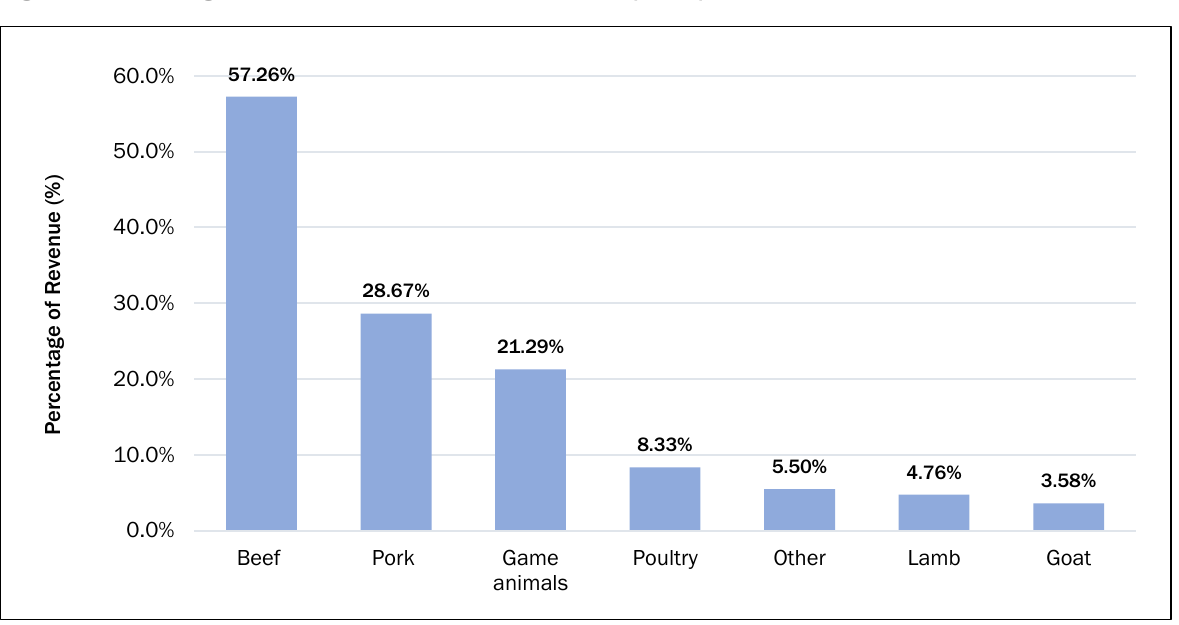
Figure 1. Percentage of Revenues from Different Animals ( N =26)